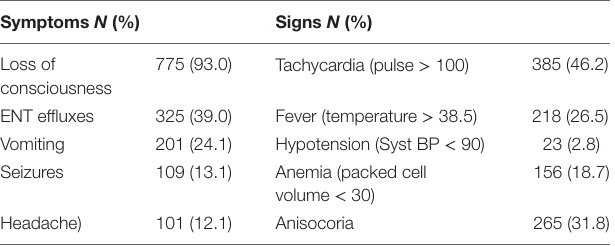
Table 2 | Road-traffic injury-related head injury from Nigeria: in-hospital symptomatology of the patients.